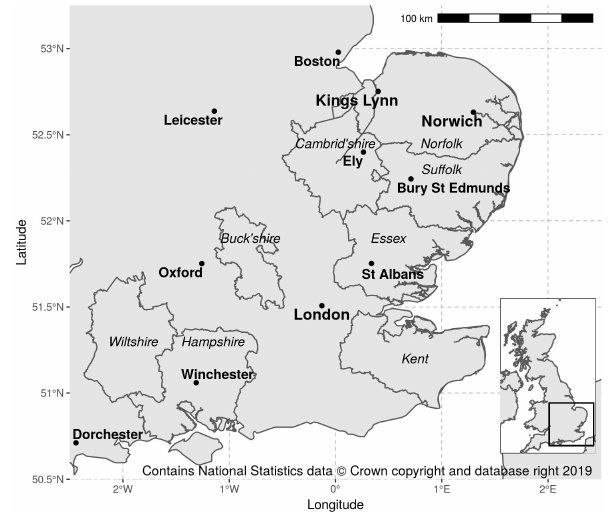
Figure 1. Map showing regions and cities in England described in the text. Counties indicate modern-day administrative